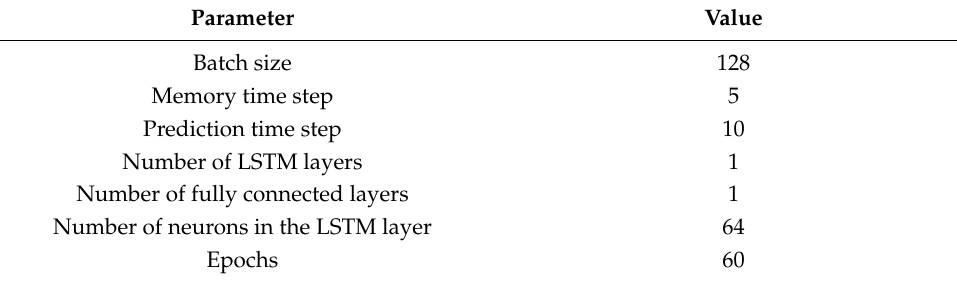
Table 4. Parameters of the LSTM car-following